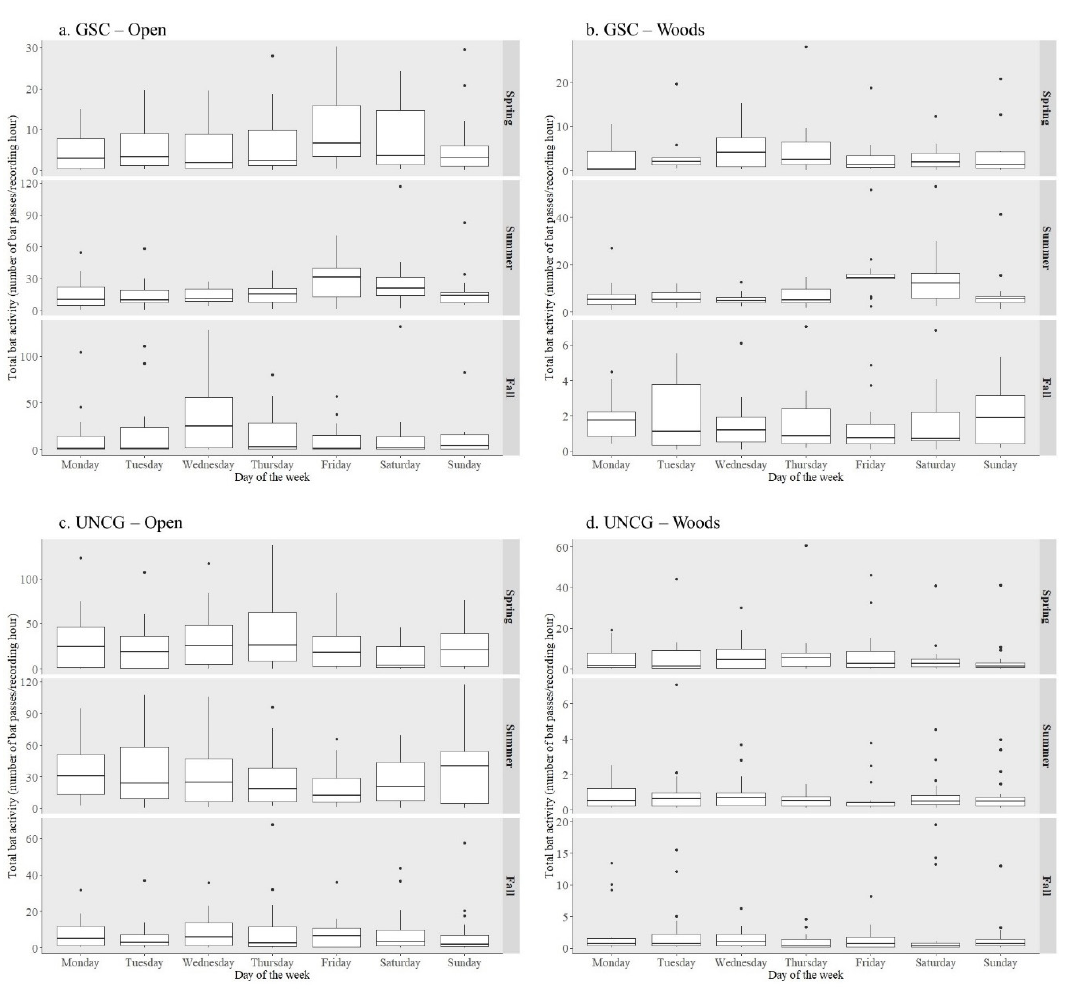
Figure 2. Quartile box plot of hourly total bat activity (all species bat passes combined) in relation to the day of the week by season from recordings collected in 2018 and 2019 at ( a ) the Greensboro Science Center (GSC) open site, ( b ) the Greensboro Science Center woods site, ( c ) the University of North Carolina Greensboro (UNCG) open site, ( d ) the University of North Carolina Greensboro woods site in Greensboro, North Carolina, USA.